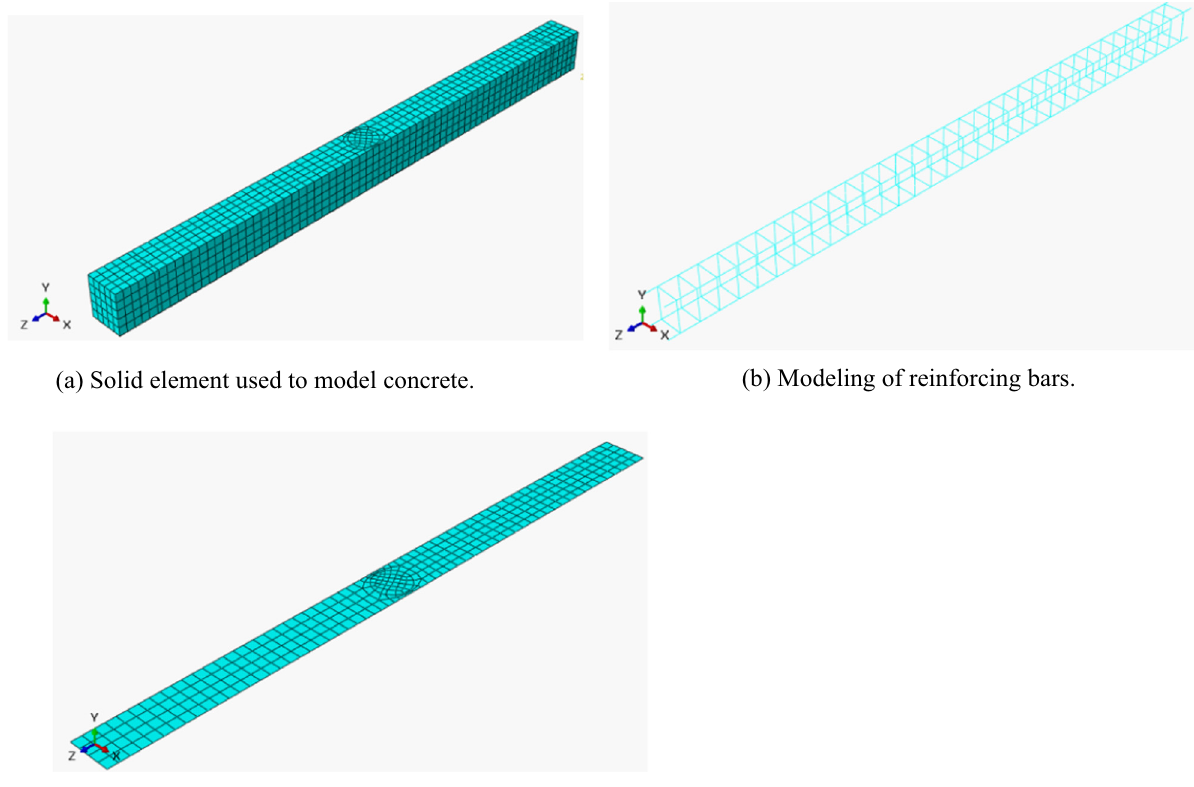
Figure 1: ( a ) Modeling concrete, ( b ) modeling of bars, and ( c ) modeling of